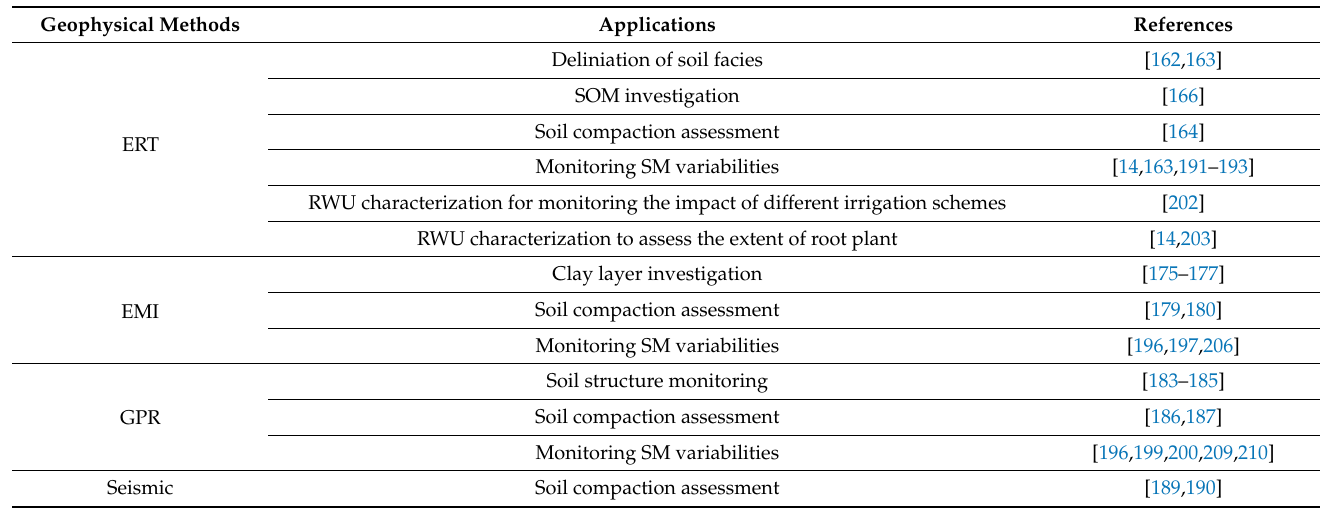
Table 4. Various geophysical methods to characterize the soil water availability and dynamic in the vadose